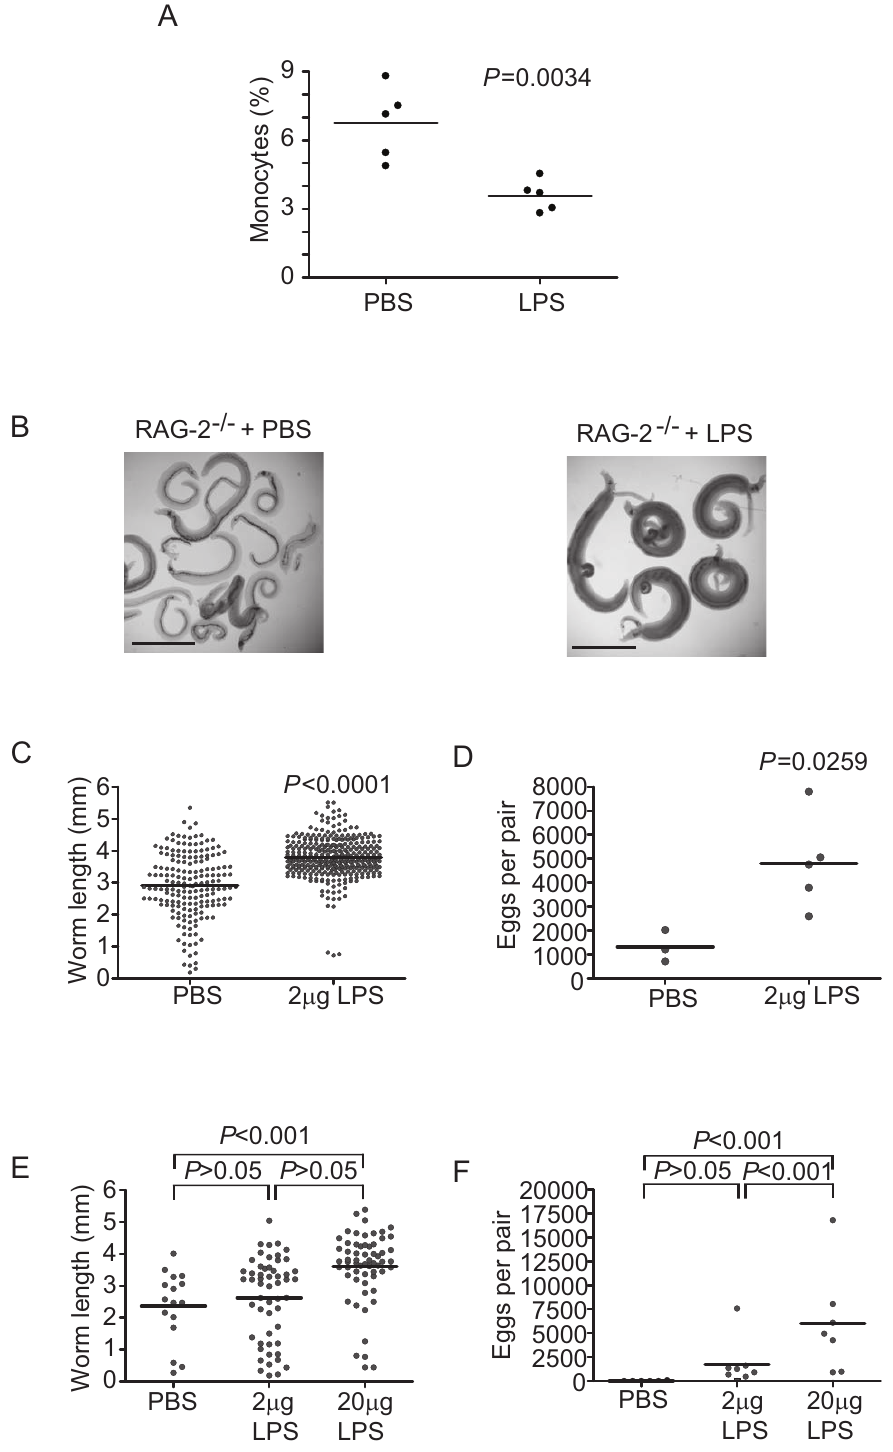
Figure 4. TLR ligand-induced maturation of mononuclear cells facilitates S.mansoni development. (A) Relative numbers of monocytes in the spleens of LPS-treated and control (PBS-treated) RAG-1 -/- mice. (B) Representative micrographs of parasites isolated from RAG-2 -/- mice at six weeks post infection after weekly treatment with 2 m g or LPS. Control animals received carrier (PBS) alone. (C) Length of male worms and (D) egg production by schistosome pairs from RAG-2 -/- BALB/c mice at six weeks post infection after weekly treatment with 2 m g or LPS. Control animals received carrier (PBS) alone. Mean values are represented by horizontal bars. (E) Length of male worms and (F) egg production by schistosome pairs from RAG-1 -/- C57BL/6 mice at six weeks post infection after weekly treatment with 2 m g or 20 m g LPS. Control animals received carrier (PBS) alone. Mean values are represented by horizontal bars. Groups of 4–5 mice were used for each experimental condition. Data are representative of at least five independent